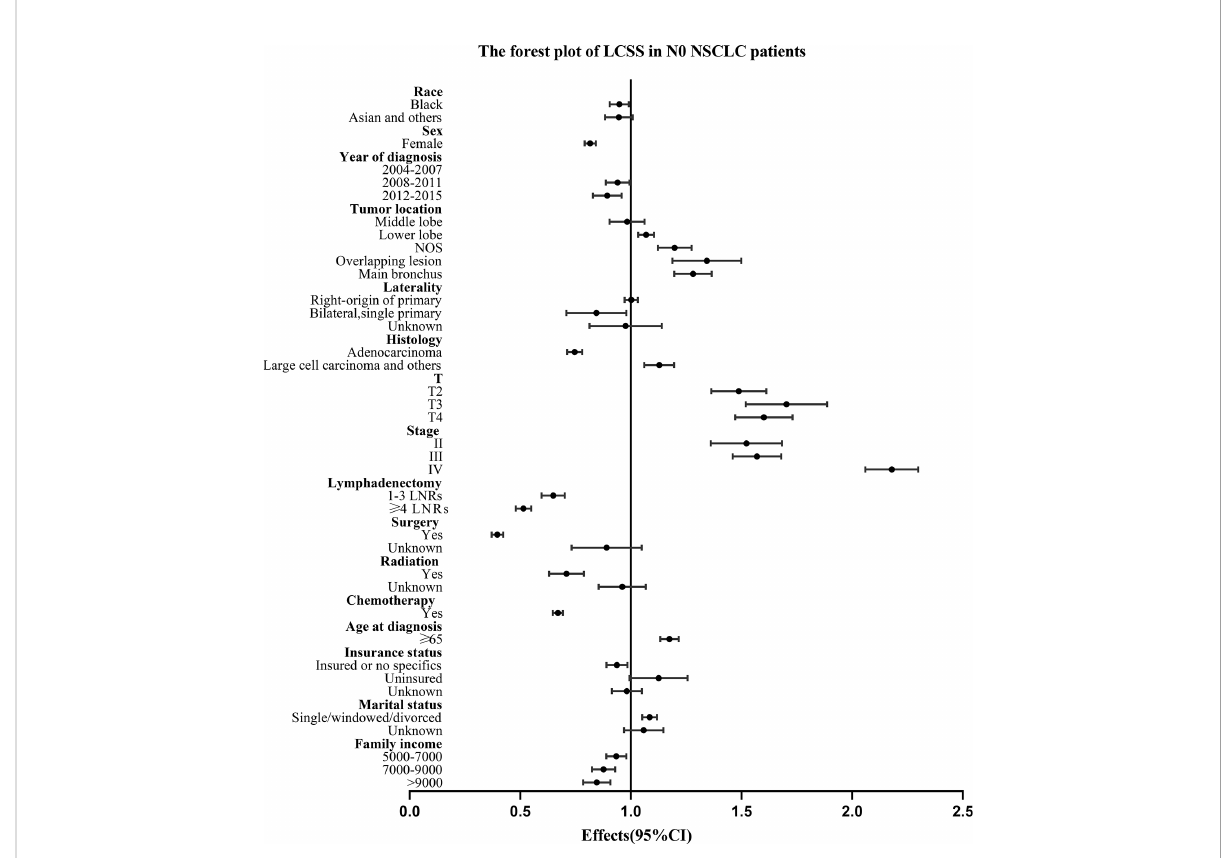
FIGURE 5 Forest plot of variables that can in fl uence LCSS in N0 NSCLC patients. NSCLC, non-small cell lung cancer; CI, con fi dence interval; LCSS, lung cancer speci fi c survival; LNRs, lymph nodes